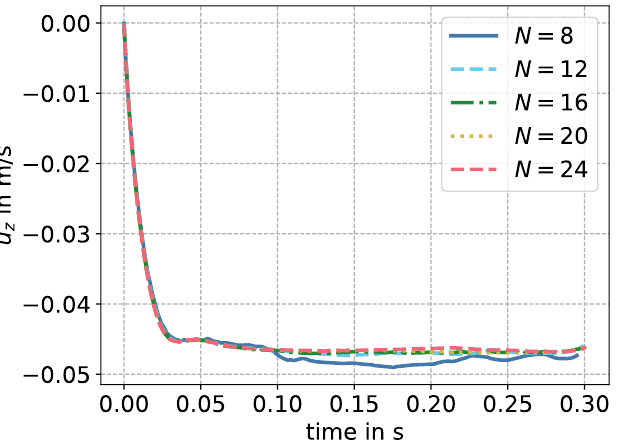
Figure 4. Coordinates of the center of mass of the particle, projected on a plane normal to the settling direction. Results printed for different grid spacings, for the particle with the shortest